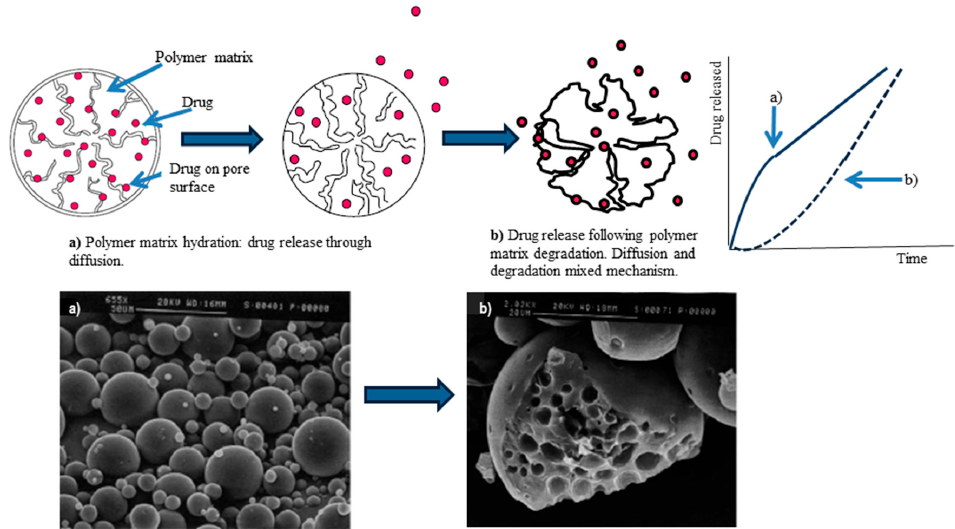
Figure 2. Scheme of “in vitro” drug release mechanisms through biodegradable polymers microspheres and correlation with scanning electron microscopy images of the drug-loaded microspheres: ( a ) immediately after incubation; ( b ) 20 days after incubation.